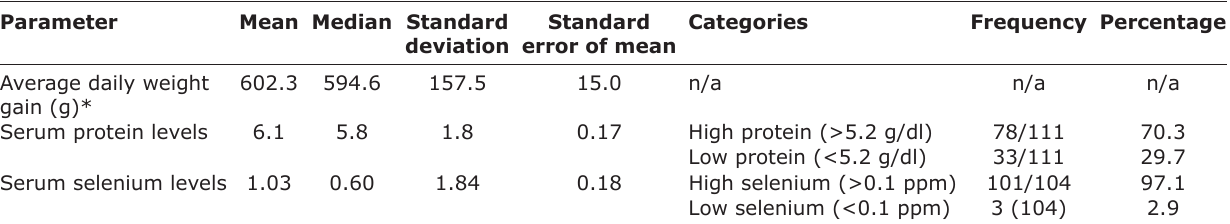
Table-3: Average daily gain and serum total protein and selenium levels of 112 calves in 110 smallholder dairy farms in Mukurwe-ini Sub-County, Kenya. Parameter